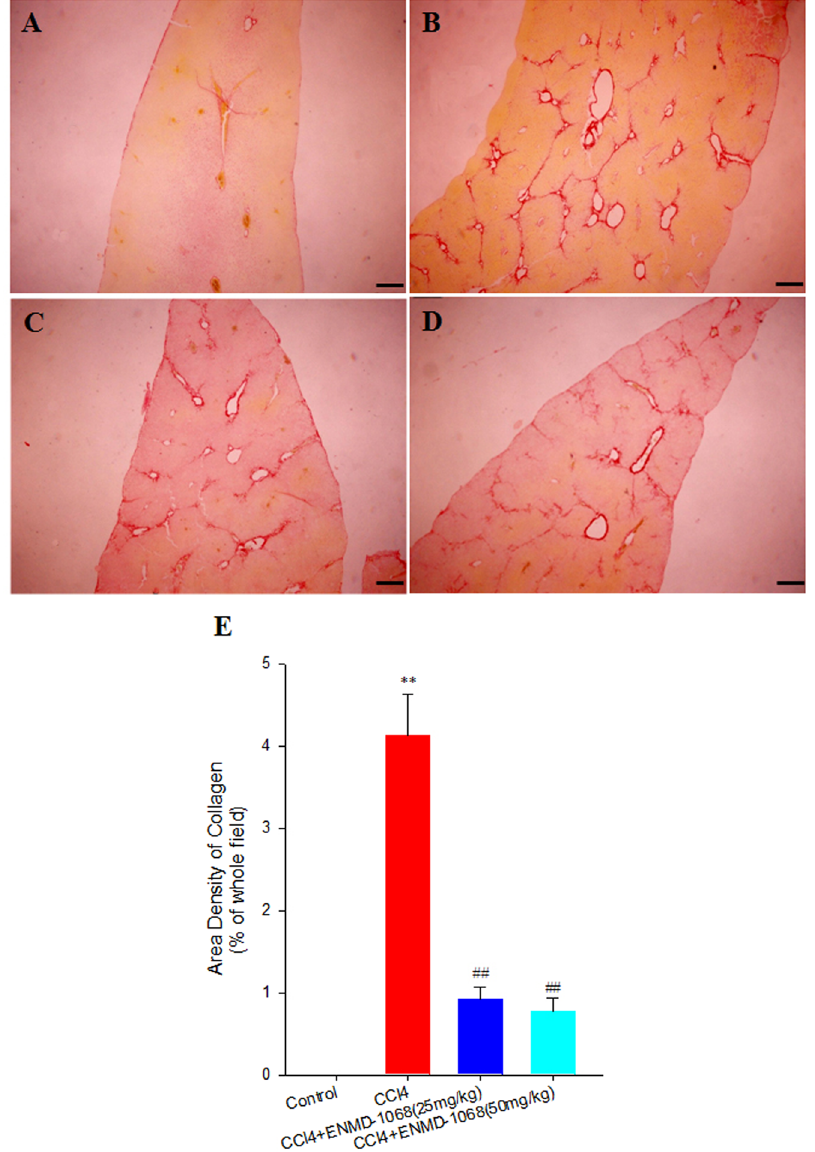
Figure 3. Sirius Red staining of collagen in liver sections. Control mice were treated with olive oil. Mice in CCl 4 group received CCl 4 twice per week. For ENMD-1068 treated mice, 25 mg/kg or 50 mg/kg ENMD-1068 were administered intraperitoneally 15 mins before CCl 4 treatment twice per week for 4 weeks. All animals were sacrificed at 4 weeks after CCl 4 treatment and liver tissues were collected for Sirius Red staining. ( A – D ) Representative images of Sirius Red staining for the ( A ) Control, ( B ) CCl 4 , ( B ) CCl 4 + ENMD-1068 (25 mg/kg) and ( D ) CCl 4 + ENMD-1068 (50 mg/kg). ( E ) Area density of collagen in representative images for each group; N = 6, bars represent SD, ** P < 0.01 vs Control, ## P < 0.01 vs CCl 4 , bar = 50 μ